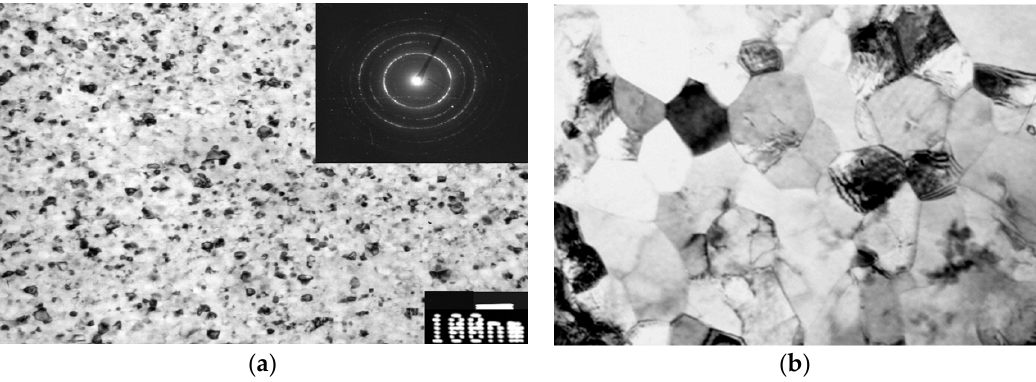
Figure 5. Microstructure of ( a ) NC and ( b ) UFG NiTi alloys processed by HPT and ECAP, respectively.